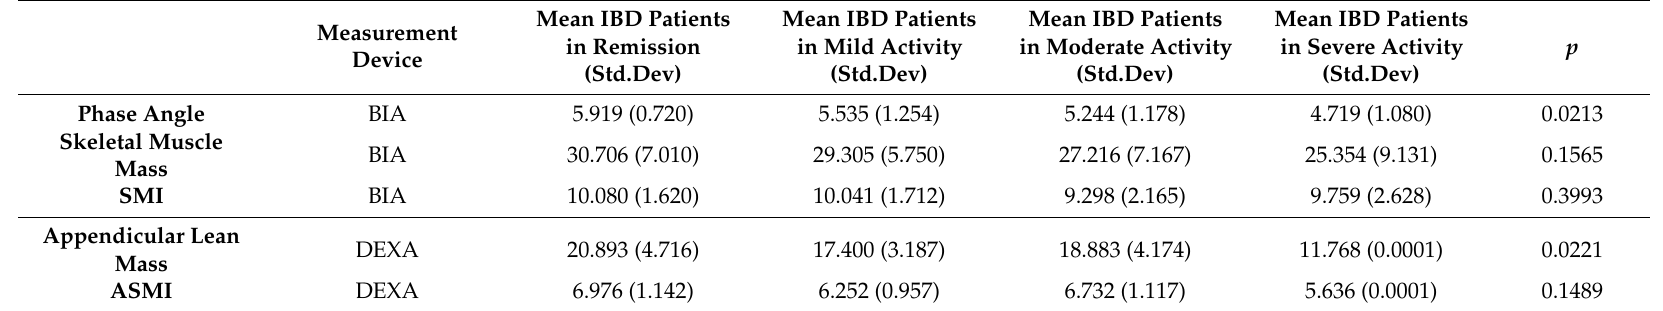
Table 4. Biometric evaluation: impact of disease